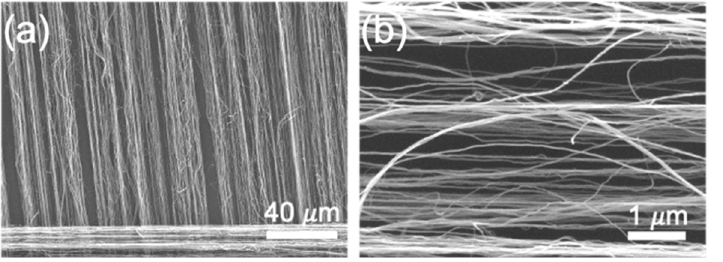
Figure 2. SEM images of drawable CNTs assembled into ribbon-like porous structures at magnifi- cations of ( a ) 650× and ( b ) 20k×.